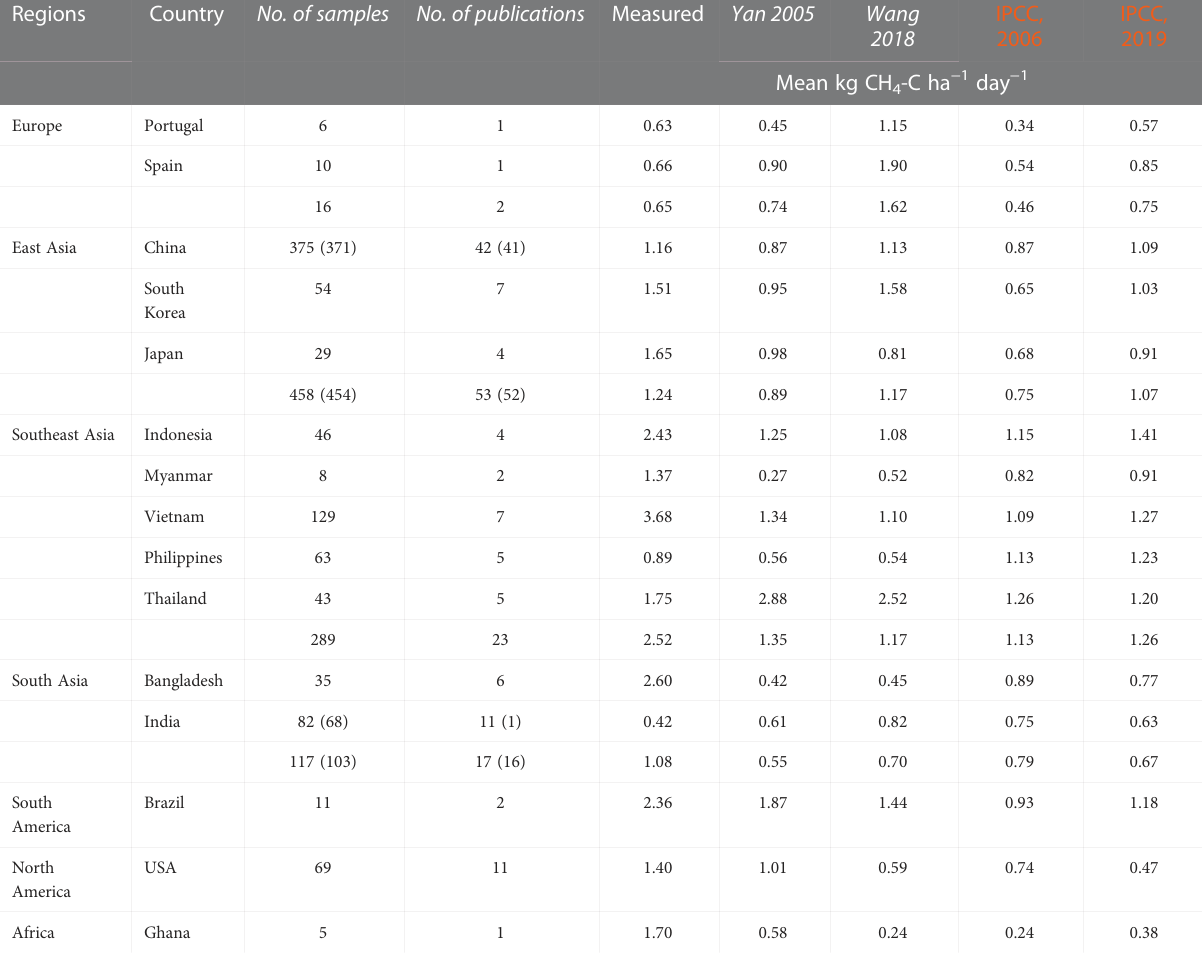
TABLE 1 List of regions, countries, and number of data points evaluated. Regions